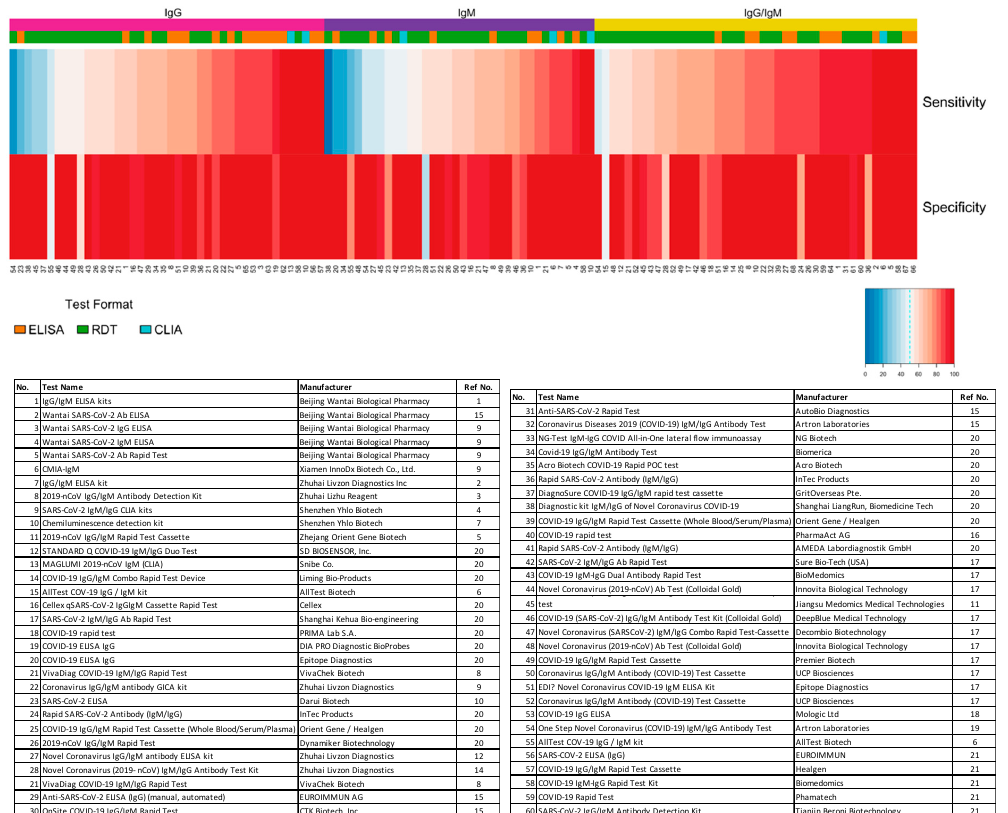
Figure 7. Independent evaluation of SARS-CoV-2 serological test overall performance. Sensitivity and specificity data from studies that did not specify the COVID-19 stage (“overall” group) are represented in a heatmap. The heatmap is ordered according to the antibody target (IgG, IgM, and IgG/IgM) followed by sensitivity and specificity values. All analyses were conducted using software R version 3.6.3. Heatmaps were generated using the gplots and RColorBrewer packages. ELISA: enzyme-linked immunosorbent assay; CLIA: chemiluminescence immunoassay; RDT: rapid diagnostic test. Table 1. Top-performing COVID-19 serological tests based on independent evaluations of sensitivity/specificity.